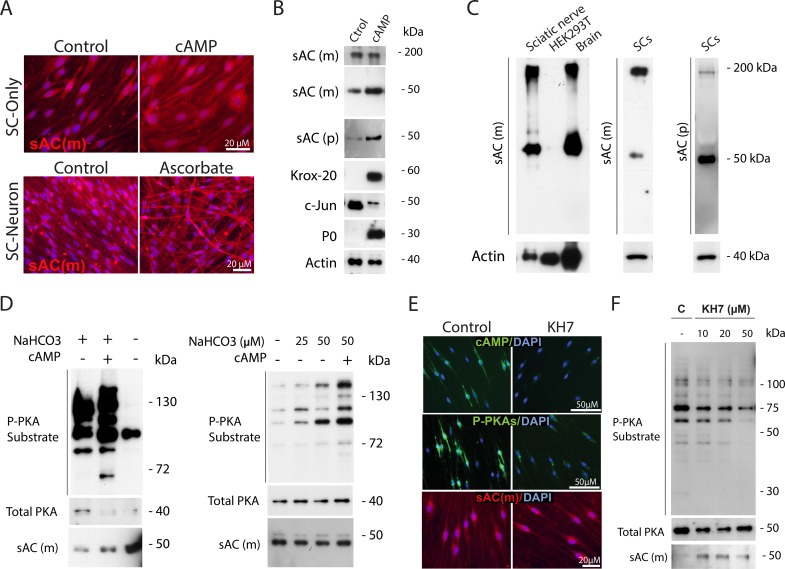
Expression and activity of sAC in cultured SCs: changes with differentiation, responsiveness to bicarbonate stimulation and pharmacological inhibition with KH7.In panel A, sAC expression was detected in non-differentiated (control) and differentiated SCs (i.e. cells treated with CPT-cAMP, 250 μM, for 3 days) and SC-neuron cultures non-treated (control) and treated with ascorbate for 12 days. Western blot analysis of control and cAMP-treated SCs with two different anti-sAC antibodies (a sAC monoclonal, sAC-m, and a sAC polycolnal, sAC-p) revealed the expression of two distinct sAC immunoreactive bands that migrated at ~180 kDa (full length sAC) and ~50 kDa (truncated sAC isoform), respectively. The ~50 kDa protein was increased upon treatment with cAMP (B). In panel C, the specificity of sAC detection was confirmed in samples of purified SCs, sciatic nerve extracts, brain extract (positive control) and HEK293T cells (negative control). In D (left panel), SCs growing in bicarbonate-containing DMEM medium (alone or together with CPT-cAMP, 250 μM) or bicarbonate-free DMEM medium for 3 days were collected for western blot analysis using antibodies against P-PKA substrates, total PKA and sAC. In D (right panels), SCs were incubated in bicarbonate-free DMEM for 24 hours and then, stimulated with the indicated concentrations of sodium bicarbonate (NaHCO3) alone or together with CPT-cAMP for an additional 24 hour period. In panels E-F, SC-only cultures were starved of mitogens and serum for 3 days and left untreated (control) or treated with KH7, which was provided at 20 μM unless otherwise indicated. Cells were treated for 30 min (E) and 24 hours (F) prior to analysis by immunofluorescence microscopy and western blot, respectively. In E, cultures were analyzed for their immunoreactivity with antibodies against cAMP (upper panels), P-PKA substrates (middle panels) and sAC (lower panel). The high levels of cAMP and P-PKA substrate expression in non-stimulated SCs, along with their sensitivity to bicarbonate stimulation and KH7 inhibition, are indicative of constitutive sAC activity.